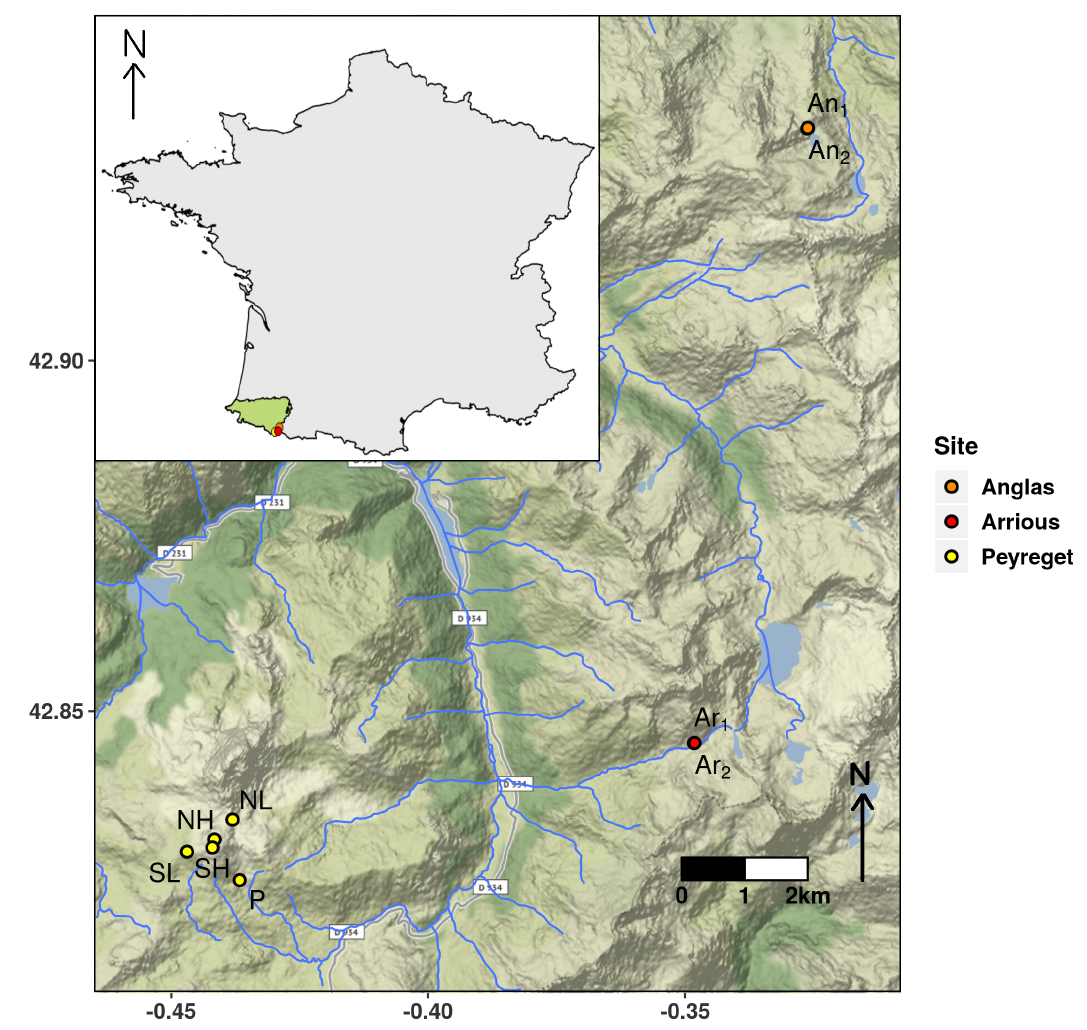
Figure 2. In France, in the department of Pyrénées-Atlantiques (in green on the France map in the top left), nine biomimetic loggers have been deployed on three study sites: Anglas—An 1 and An 2 ; Arrious—Ar 1 and Ar 2 ; and Peyreget—NL, NH, SL, SH, and P. The highest density is observed at the Arrious site (in red), the lowest at the Peyreget site (in yellow). The Anglas site (in orange) has a medium density. The hydrographic network is drawn in blue. Map source: Stamen, extracted with the get_map function on